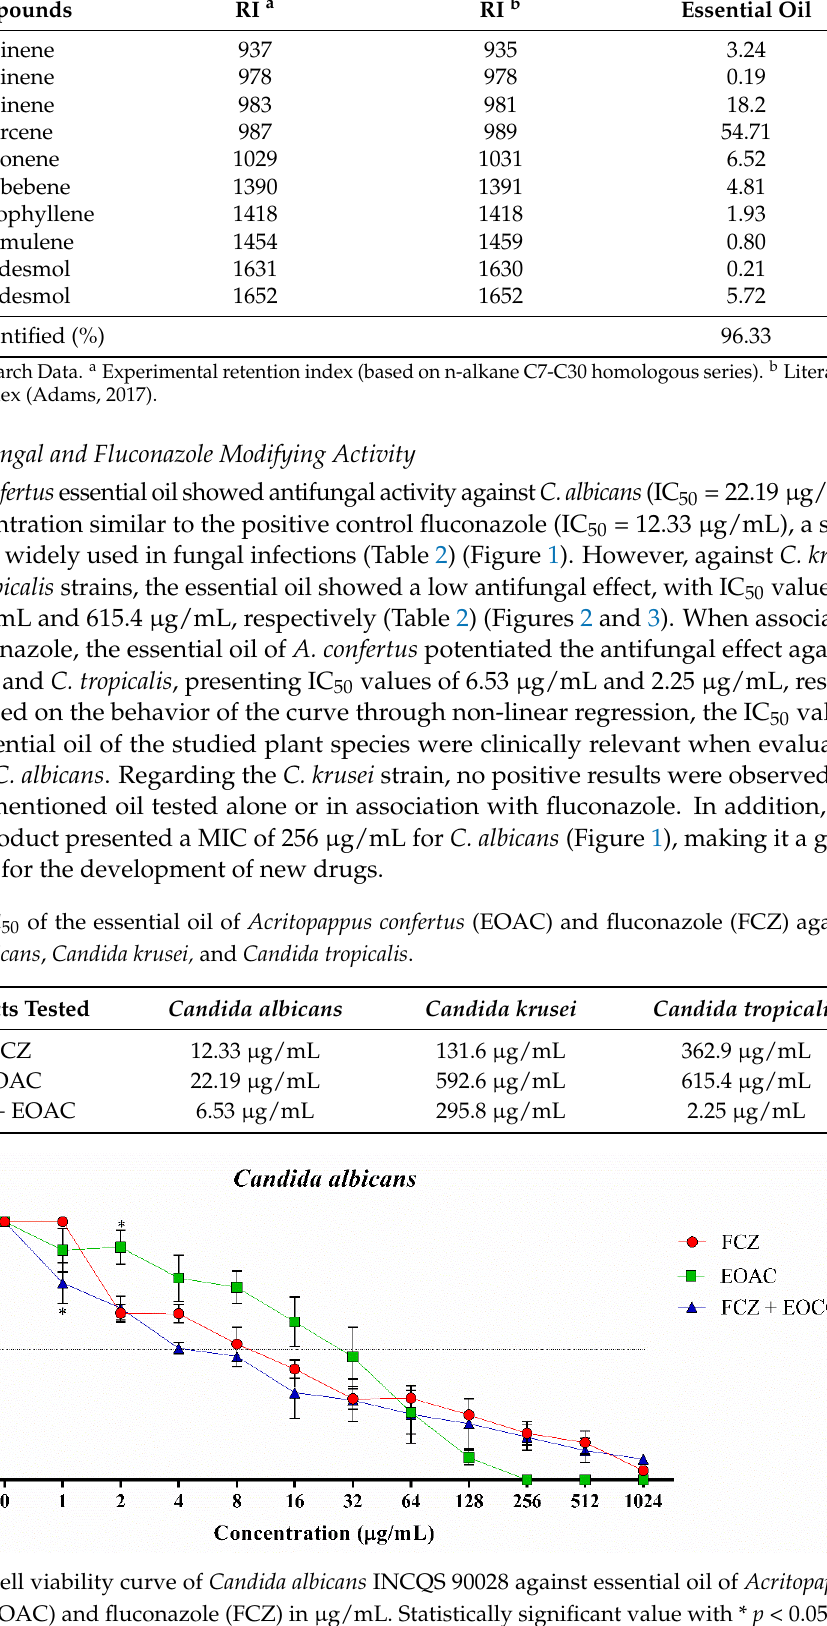
Figure 2. Cell viability curve of Candida krusei INCQS 40095 against essential oil of Acritopappus confertus (EOAC) and f luconazole (FCZ) in μg/mL. Statistically significant value with **** p < 0.0001. Figure 3. Cell viability curve of Candida tropicalis INCQS 40042 against essential oil of Acritopappus confertus (EOAC) and f luconazole (FCZ) in μg/mL. Anti - Candida potential of essential oil of Acritopappus confertus against strains of Candida tropicalis . Statistically significant value with * p < 0.05, ** p < 0.01, *** p < 0.001 and **** p < 0.0001. 2.3. Anti-Virulence Potential The analysis of the effect of the essential oil of A. confertus on the morphology of the yeasts of C. albicans was carried out through the depletion of the culture medium, stimu- lating the yeast to seek nutrients through the emission of hyphae and pseudohyphae. To control the growth of C. albicans (Figure 4, Slide 1), it is possible to verify the formation of